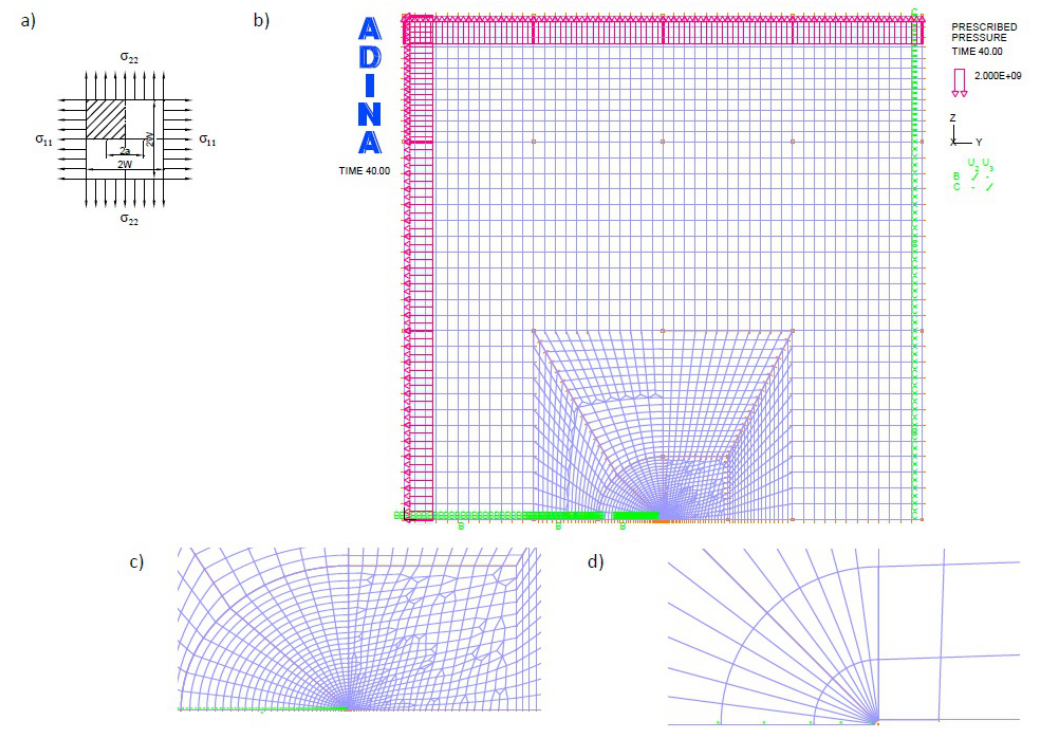
Figure 5: Numerical model of the CCSP(BT) used to determine the limit loads for the plane stress or plane strain cases: a) fragment of the specimen modelled in the ADINA program; b) general model; c) magnified fragment of the mesh near the crack tip; d) model of the crack tip [12,